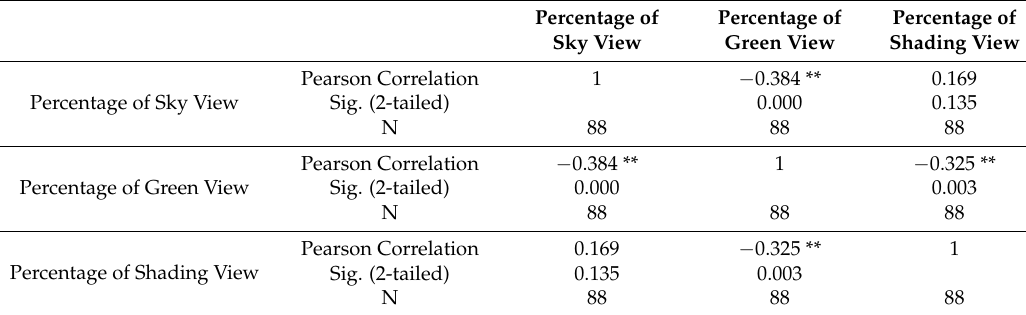
Table 2. Correlation table for the three outdoor view elements.